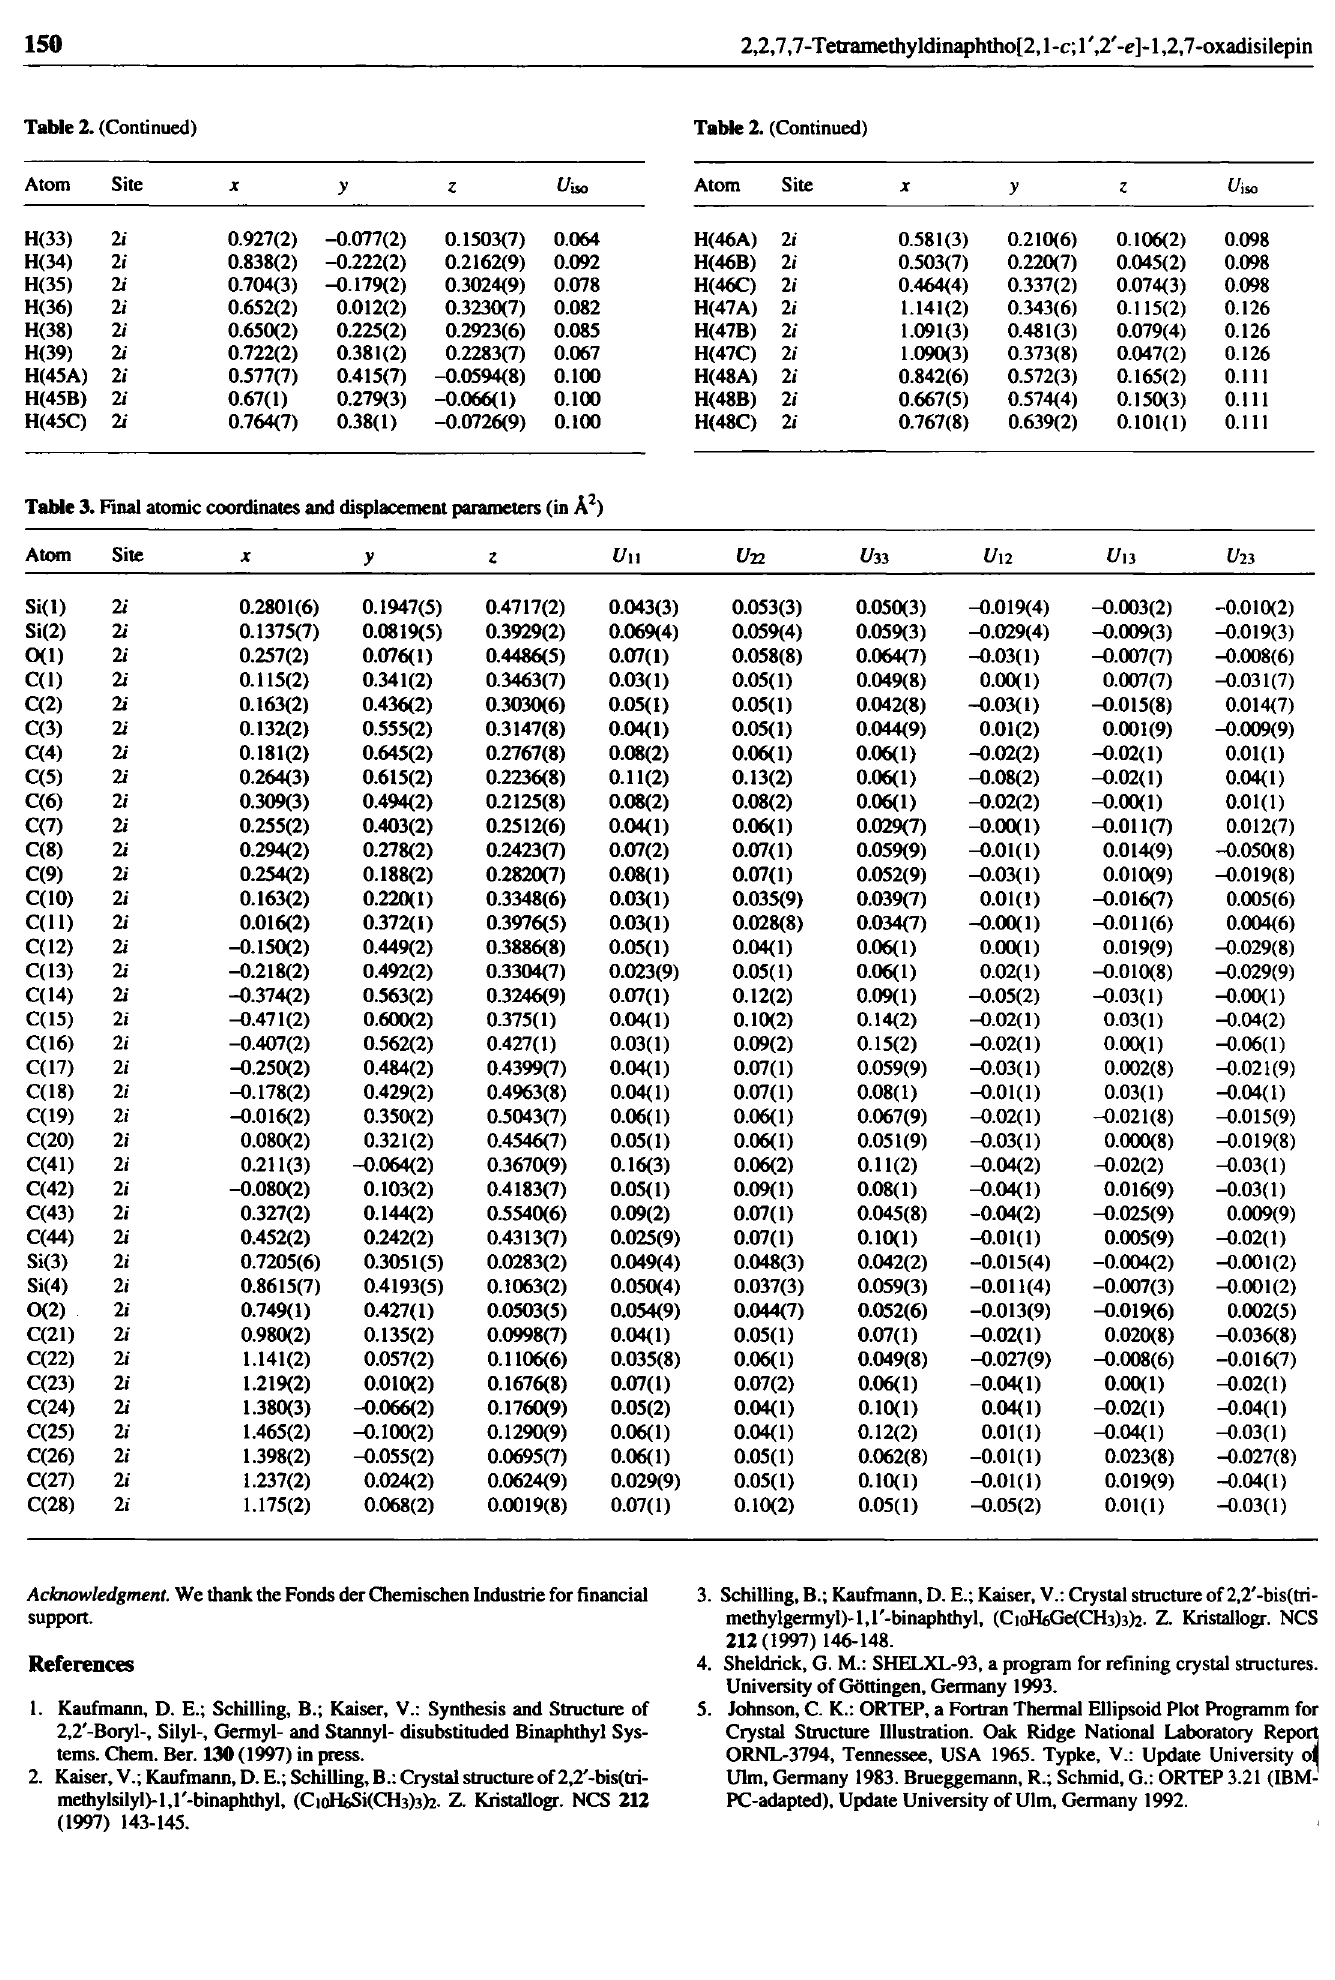
Table 3. Final atomic coordinates and displacement parameters (in Â 2